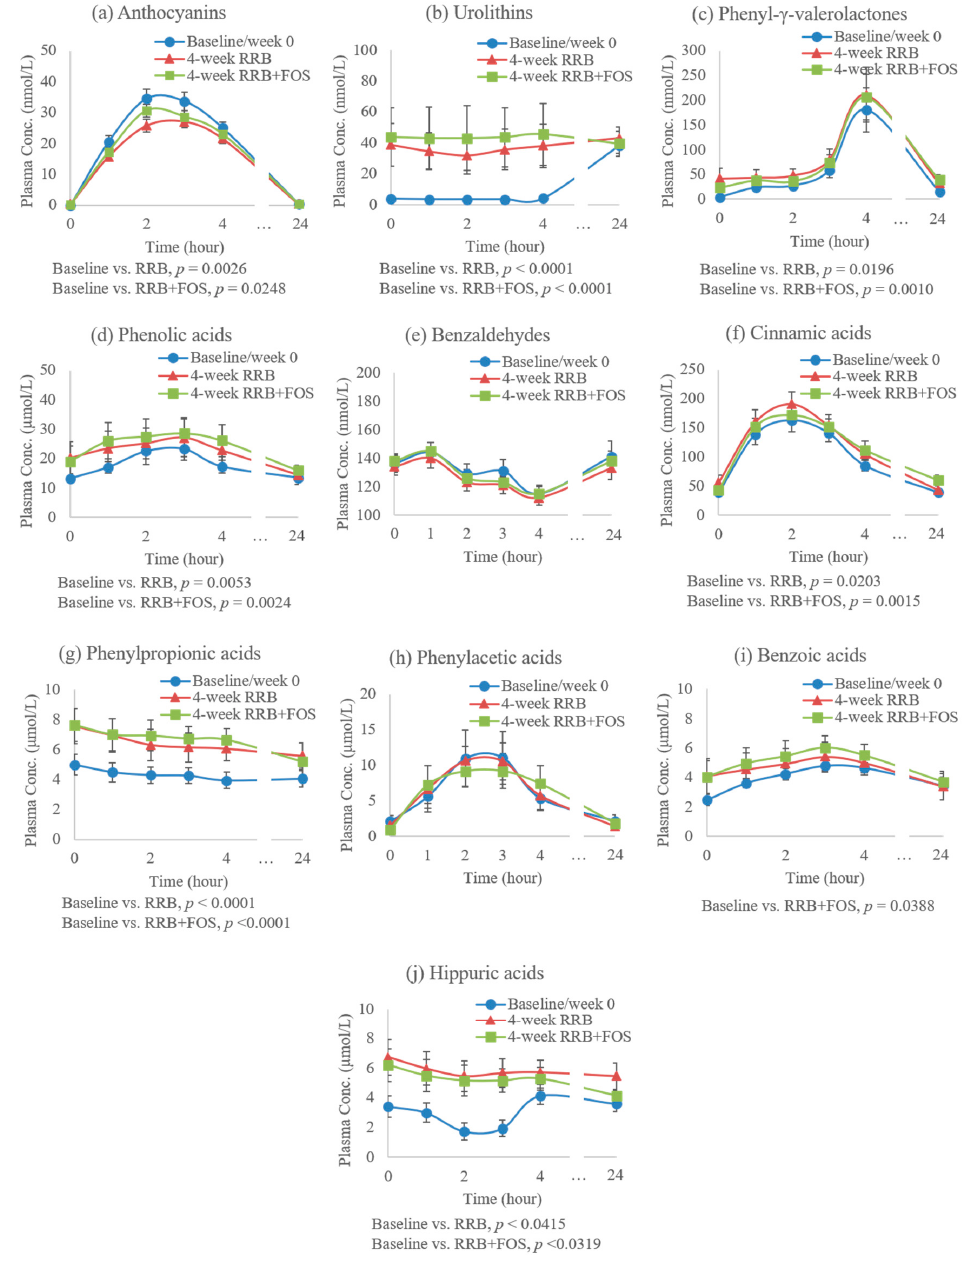
Figure 3. (Poly)phenolic metabolites concentrations in human plasma (0–24 h) post-consumption of RRBtest drink at the baseline / week 0, after 4-week RRB and 4-week RRB + FOS supplementations: ( a ) total anthocyanin derivatives; ( b ) total urolithin derivatives; ( c ) total phenyl- γ -valerolactone derivatives; ( d ) total phenolic acid derivatives; ( e ) total benzaldehyde derivatives; ( f ) total cinnamic acid derivatives; ( g ) total phenylpropionic acid derivatives; ( h ) total phenylacetic acid derivatives; ( i ) total benzoic acid derivatives; and ( j ) total hippuric acid